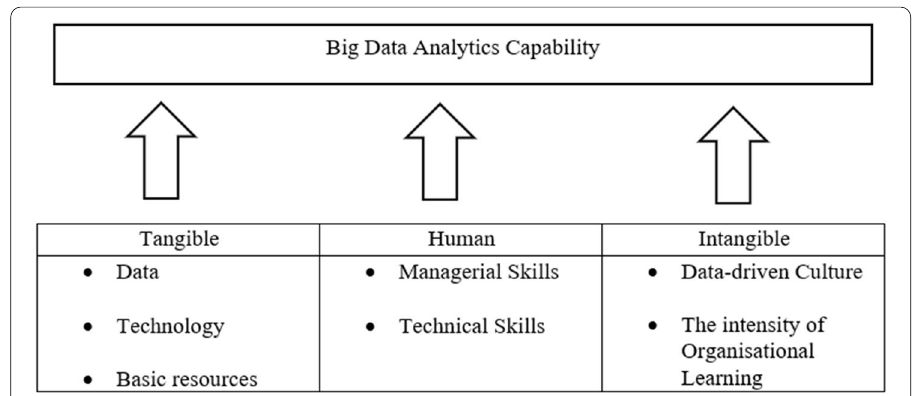
Fig. 5 Classification of Big Data resources (adapted from [16])